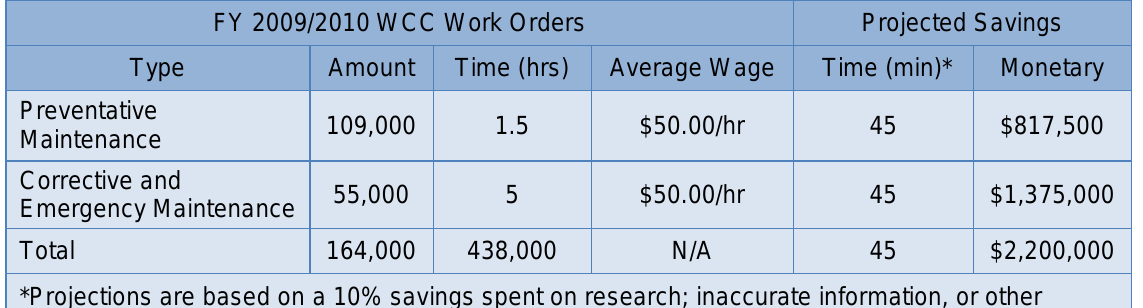
Table 1 Projected Cost Savings for Completed Work Orders Industry Standards for BIM to